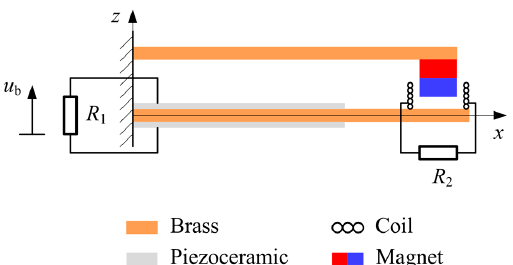
Figure 1. Schematic diagram of the proposed frequency up-converting hybrid energy harvester (FUCHEH).